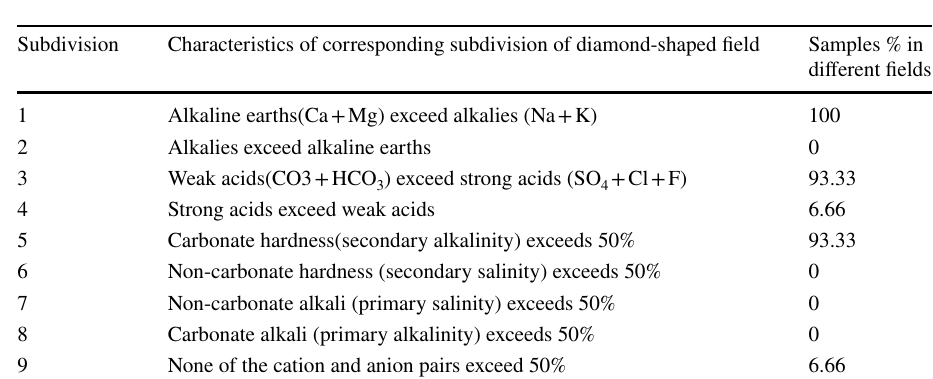
Table 4 Hydrochemical facies derived from piper diagram